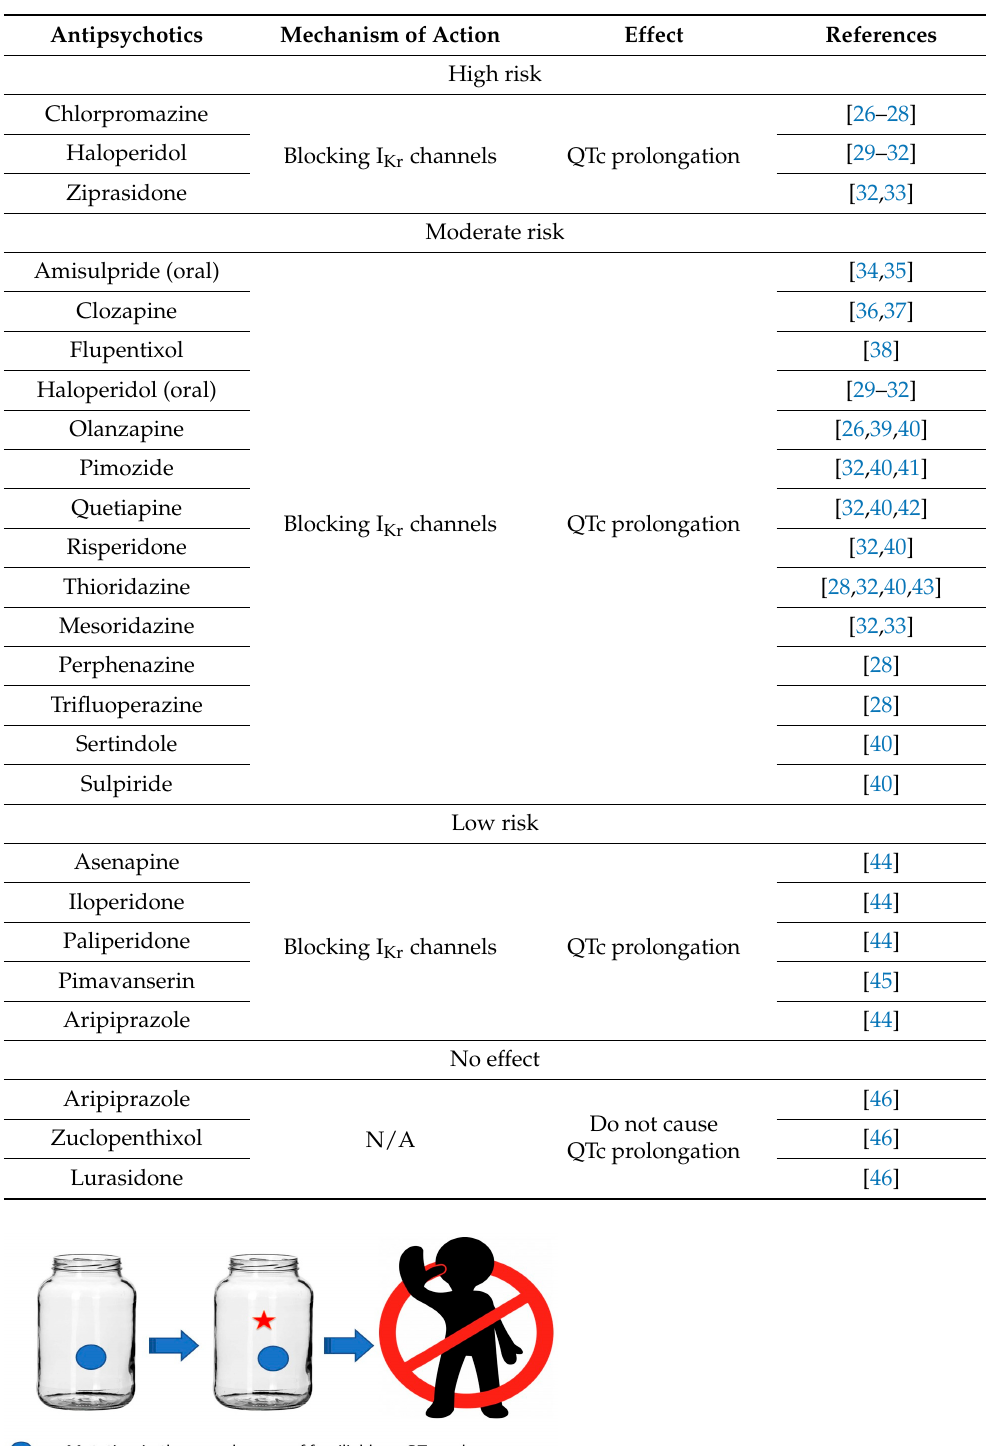
Table 2. Mechanism of action and effect of antipsychotics used to treat schizophrenia on resting heart rate and conduction.